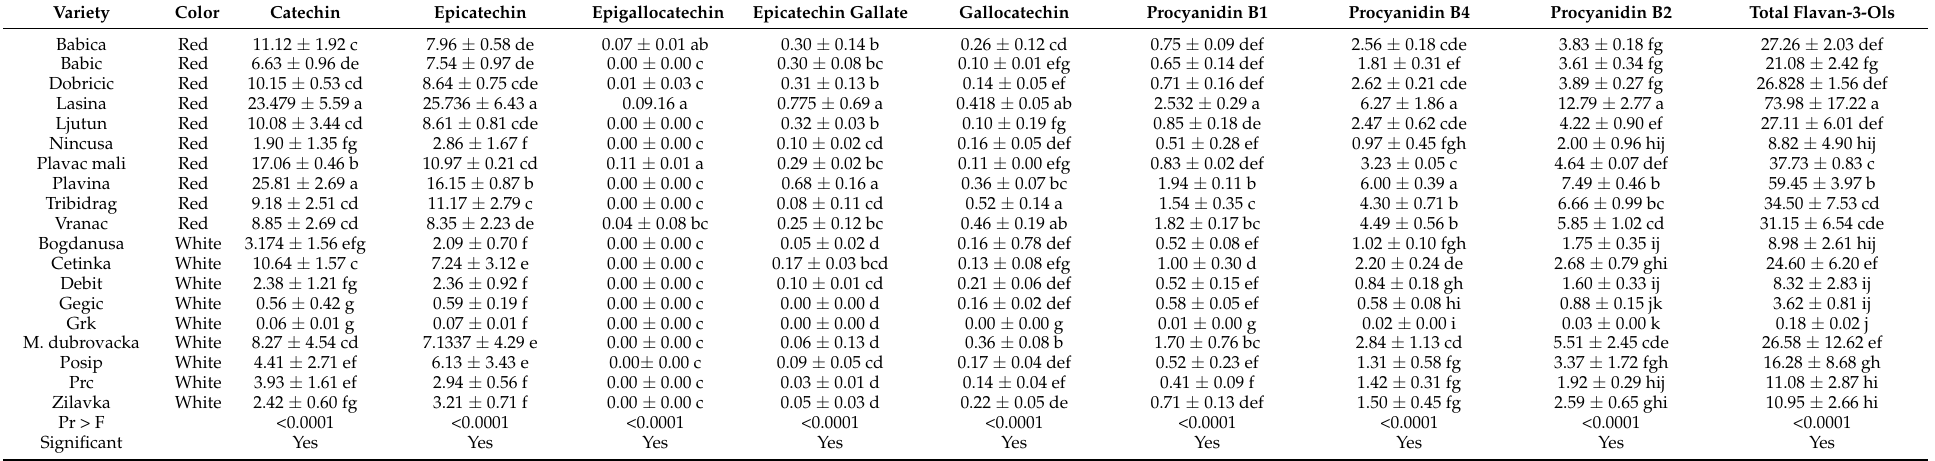
Table 4. Prediction of flavan-3-ols yield (kg/ha) when grape yield is 10 t/ha. Means with different letters in the same column differ significantly ( p ≤